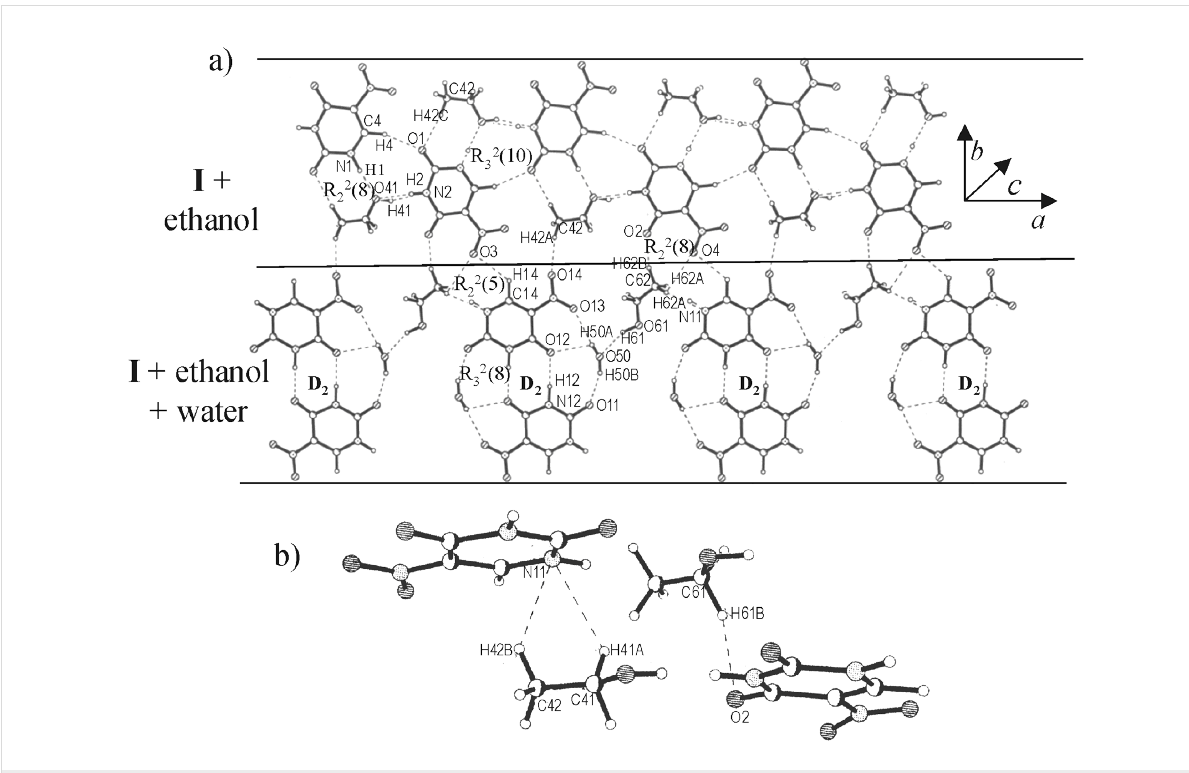
Figure 6: Cocrystal of I , ethanol and water: (a) A molecular layer showing tapes of mixed compositions- tapes containing I and ethanol alternating with those containing I , ethanol and water, (b) Hydrogen bonds connecting adjacent layers.